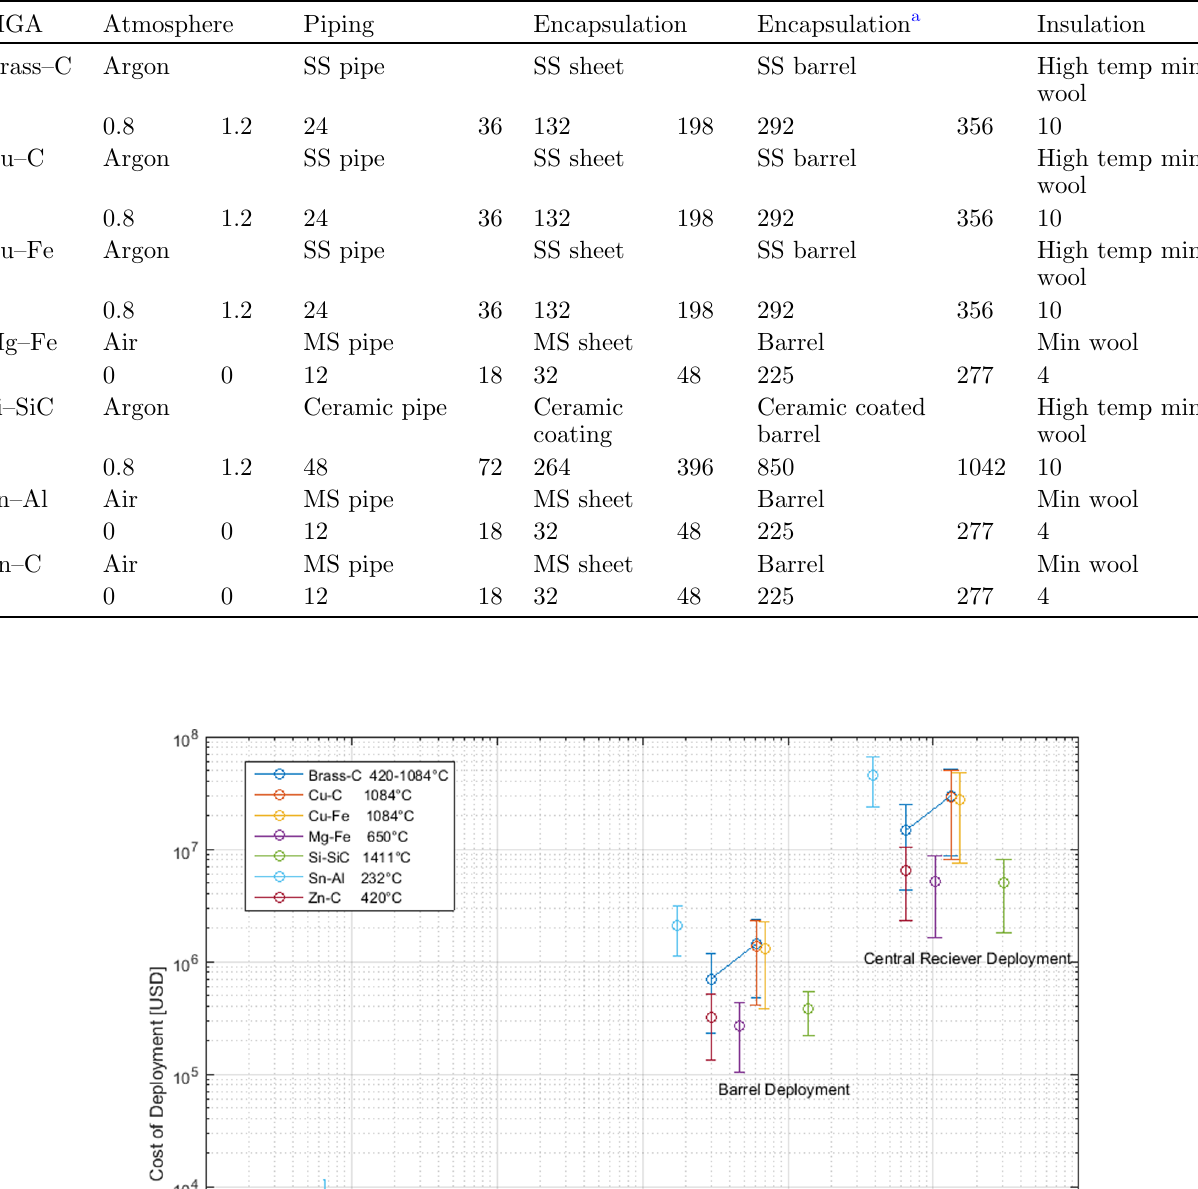
Table 2. Recommended infrastructure elements and price bounds for MGA deployments.